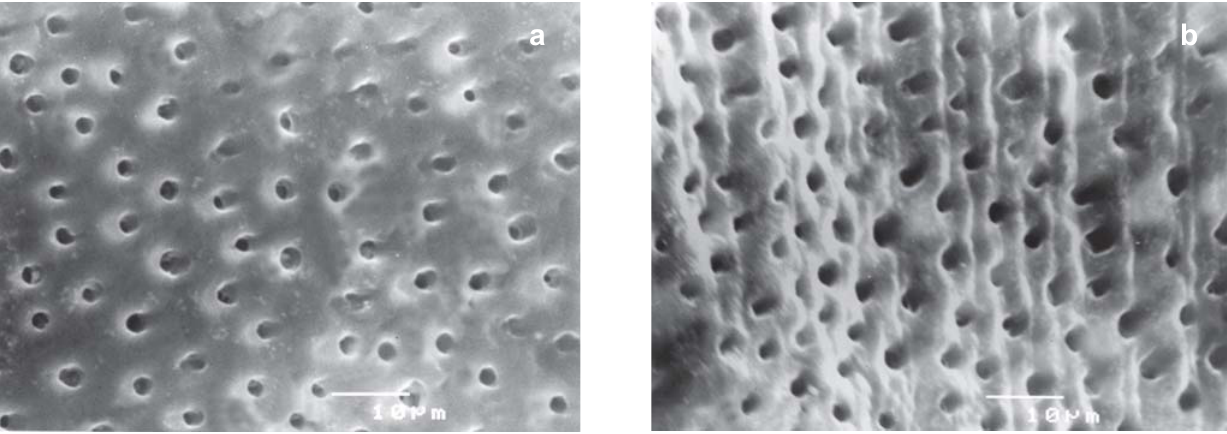
FIGURE 4- Dentin surface cut by: a) carbide bur after 37% phosphoric acid etching; b) diamond bur after 37% phosphoric acid etching (Original magnification 1500X, bar=10µm)